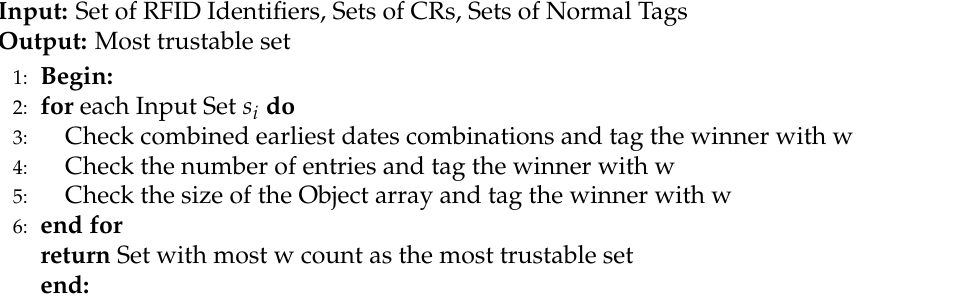
Algorithm 4 Selecting most trustable